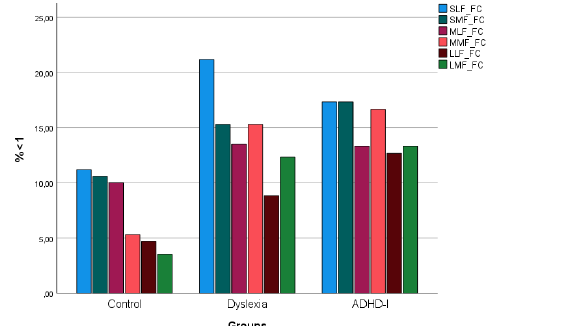
Figure 2 – Percentage of skipped target words. Note. S = Short words. M = Medium words. L = Long words. LF = Low fre- quency. MF = Medium